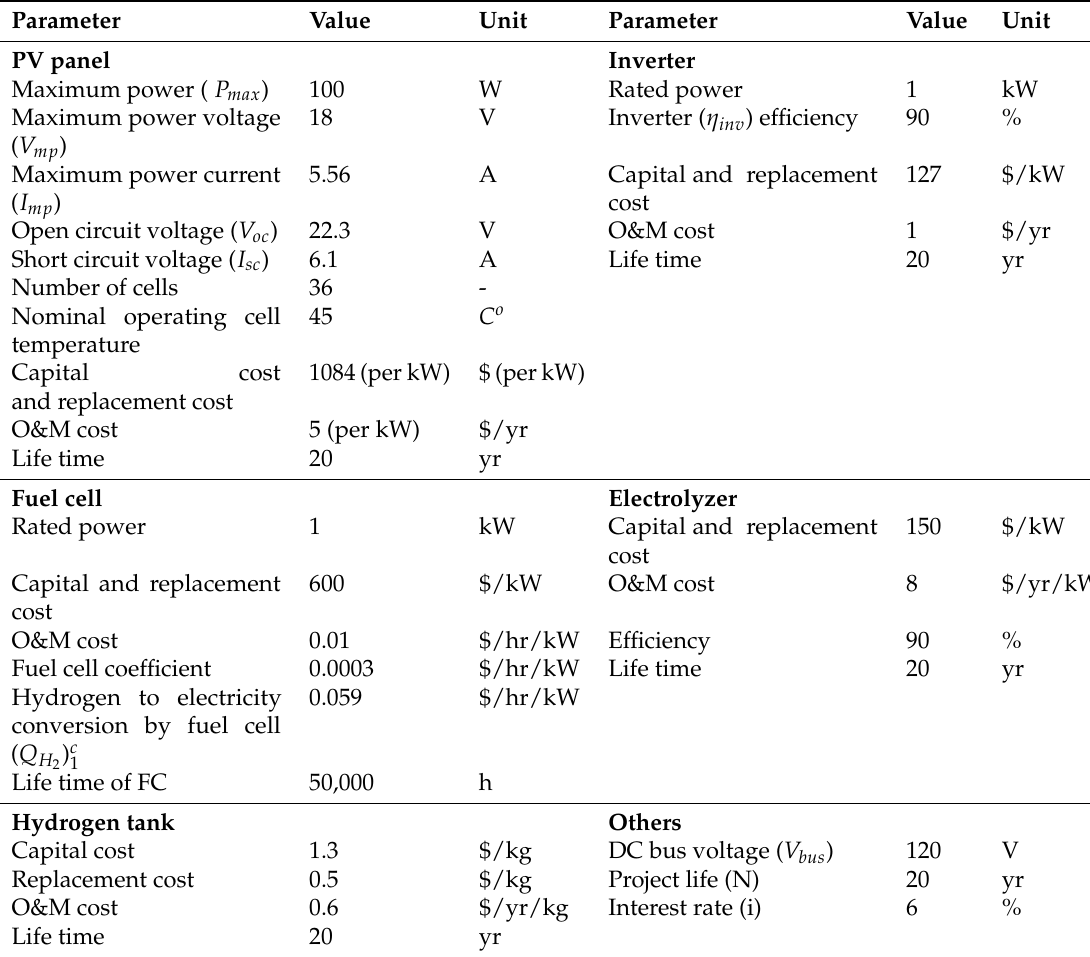
Table 1. System component specifications and their costs